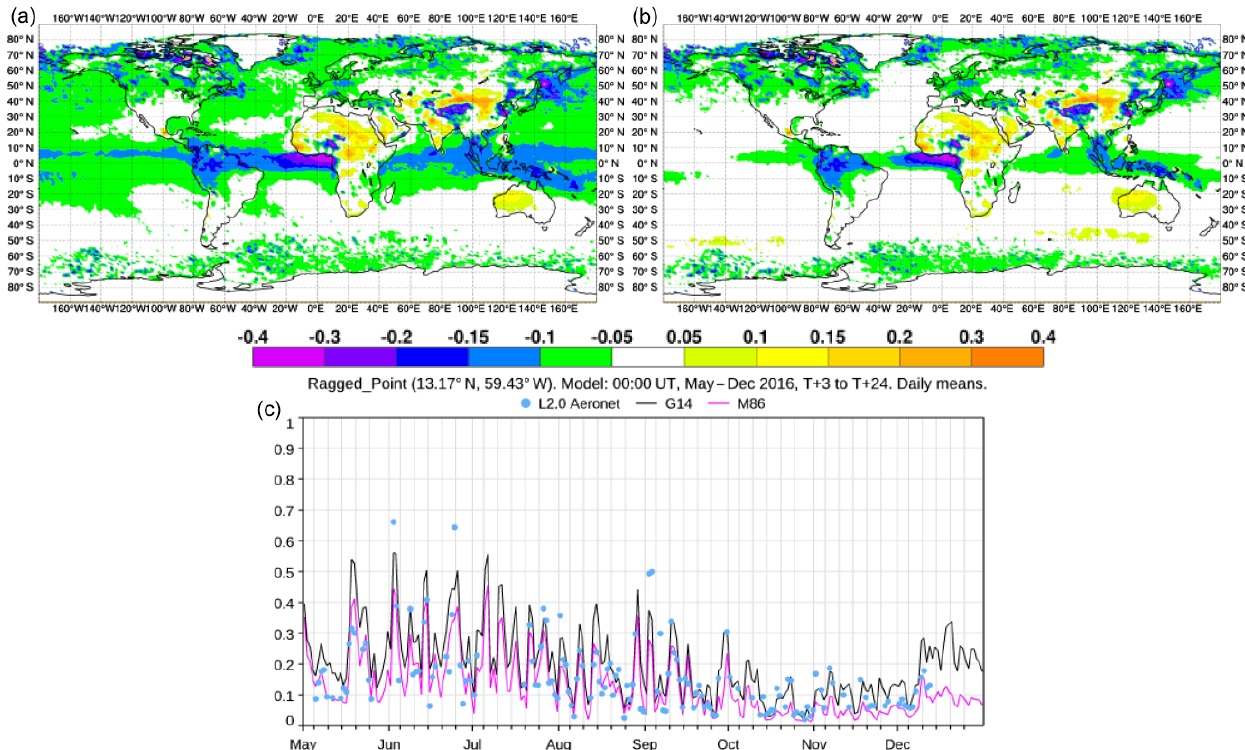
Figure 3. The 2017 bias of simulated total AOD at 550nm against MODIS Aqua collection 6.1 AOD; M86 (a) and G14 (b) . (c) May– December 2016 daily AOD at 500nm at the Ragged Point AERONET station, with observations from L2.0 AERONET (blue points), simulated by cycling forecast only IFS-AER using the M86 scheme (violet), and simulated by cycling forecast IFS-AER using the G14 scheme